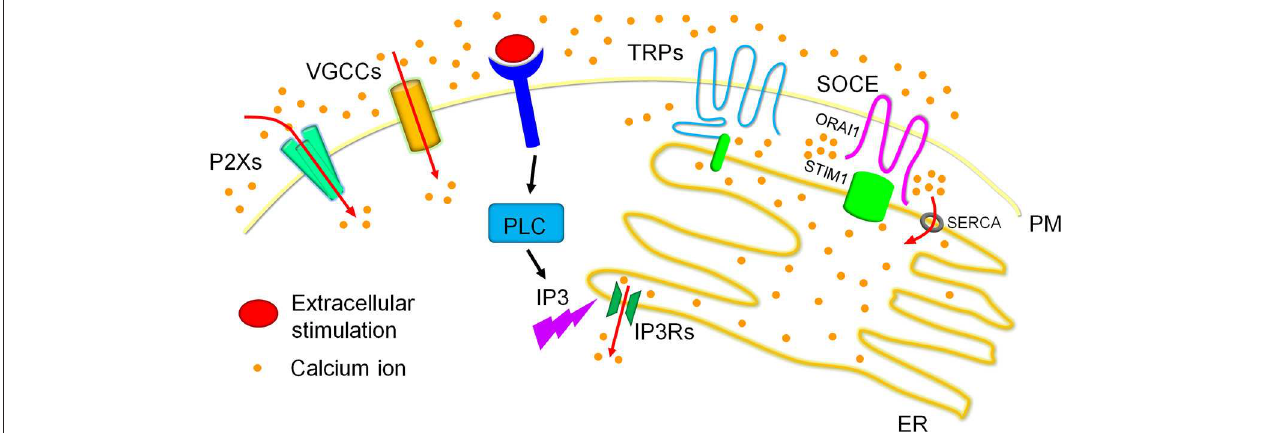
FIGURE 2 | Calcium homeostasis in cells. Calcium ions are dynamically fluxed among extracellular calcium pools, intracellular calcium storages and the cytoplasmic matrix. Four major calcium channels/routes mostly on the plasma membrane (PM) mediate extracellular calcium entry, including P2Xs, VGCCs, TRPs, and SOCE, of which TRPs and SOCE have been reported to modulate dynamic calcium fluxes in response to the reduction of calcium concentrations in the ER calcium storage. Particularly, extracellular stimulation activated PLC family members result in the production of IP3. The produced IP3 swiftly binds to IP3Rs on the ER membrane and triggers ER calcium release, which leads to the reduction of ER calcium storage. The reduced ER calcium storage activates calcium release-activated channels (CRAC) for extracellular calcium entry to refill the ER calcium ions and therefore sustain cytosolic calcium signals. TRPs especially TRPCs and SOCE have been reported to mediate CRAC. TRPCs have been shown to associate with STIM1 on the ER membrane to generate the channel for calcium entry. SOCE, the best recognized route for CRAC in recent decade, is mediated by ORAI1 on the PM and STIM1 on the ER membrane. Briefly, STIM1 is inactivated when calcium concentrations are maintained highly in the ER calcium storage, and underwent conformational change after the reduction of ER calcium contents, specifically initiated after ∼ 25% reduction. The conformational changed STIM1 are then oligomerized and redistributed to the ER-PM contact to interact with the clustered ORAI1, forming the calcium channel for extracellular calcium entry. These entered calcium ions can enter the ER calcium storage via the SERCA on the ER